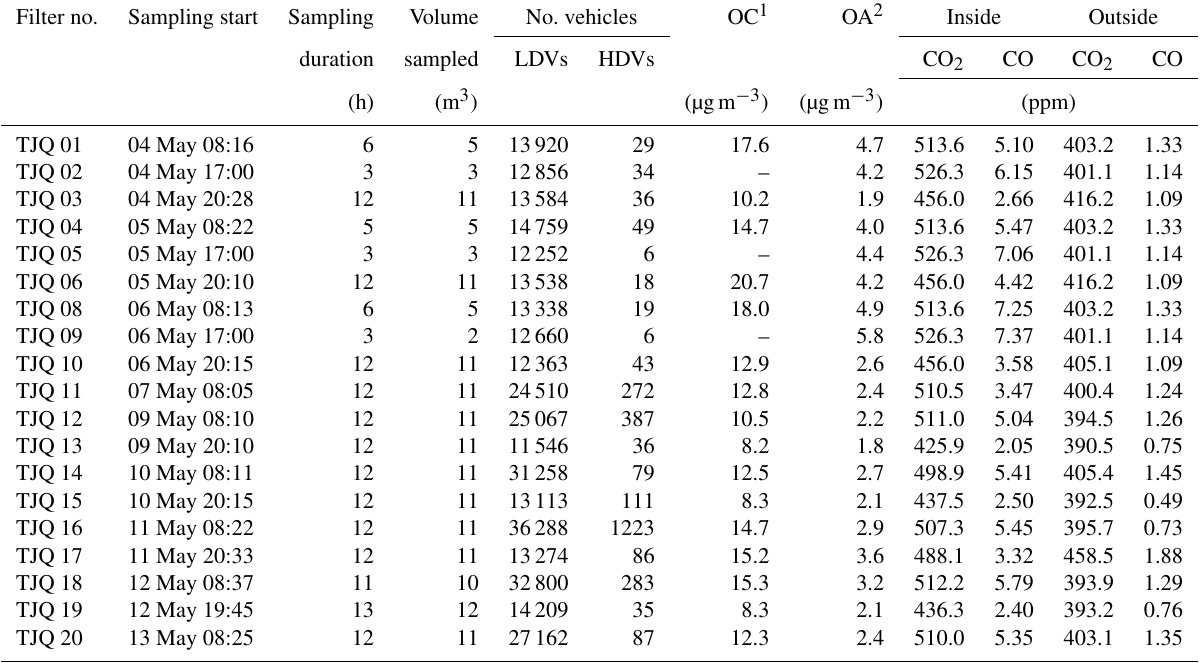
Table 1. Filter identification number, sampling start time, sampling duration, volume sampled for organic aerosol (OA) samples, vehicle counts, organic carbon (OC) and OA concentrations, and average CO 2 and CO concentrations during sampling inside and outside of the TJQ tunnel during